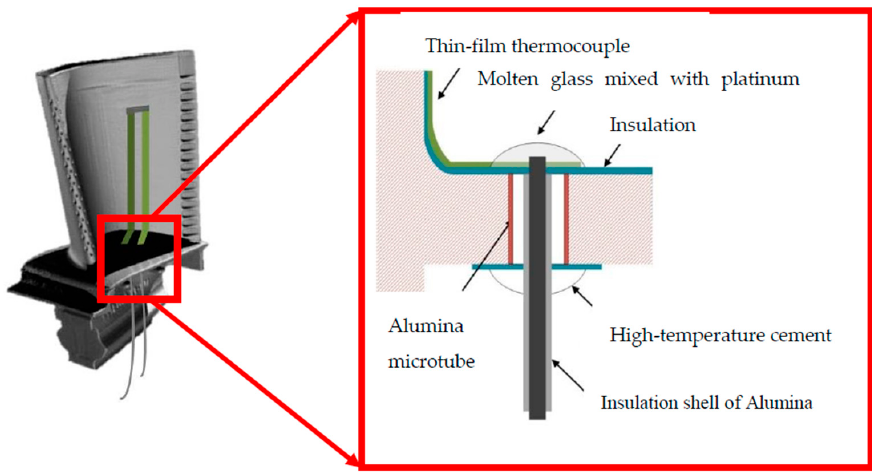
Figure 1. Structural diagram of the turbine blade through-hole lead connection.